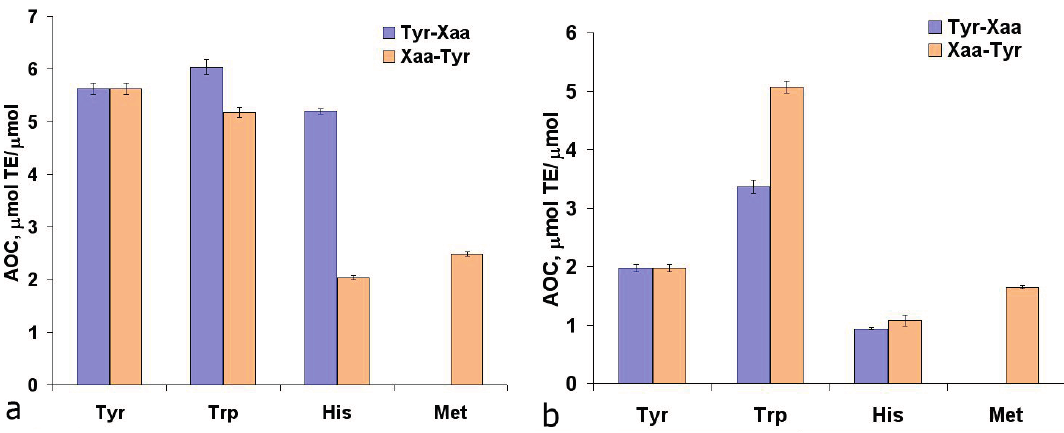
Figure 3. Mutual effects of redox-active amino acid residues on the antioxidant capacity of tyrosine dipeptides against the ABTS cation-radical ( a ) and the peroxyl radical ( b